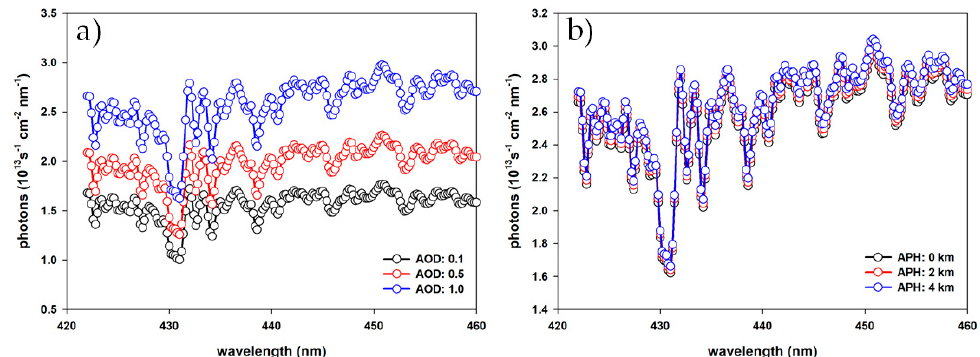
Figure 3. Synthetic radiances as a function of wavelength with ( a ) AOD of 0.1, 0.5, and 1.0 (SZA = 20°; VZA = 20°; RAA = 50°; SSA = 0.95; APH = 0 km), and ( b ) APH of 0, 2, and 4 km (SZA = 20°; VZA = 20°; RAA = 50°; SSA = 0.95; AOD = 1.0). (Aerosol optical depth (AOD), solar zenith angle (SZA), viewing zenith angle (VZA), relative azimuth angle (RAA), single scattering albedo (SSA) and aerosol peak height (APH)).